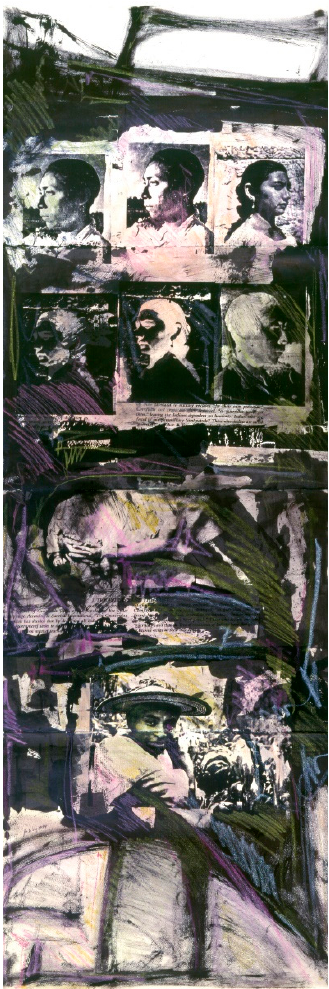
Figure 11. Josely Carvalho, Rape of a Culture , 1984, silkscreen, Indian ink and crayon on paper, 88 × 30 inches. Courtesy of the artist. Image credit: Sarah Welss, used by permission. ED What photographs were you working with for Craters of Blood ?